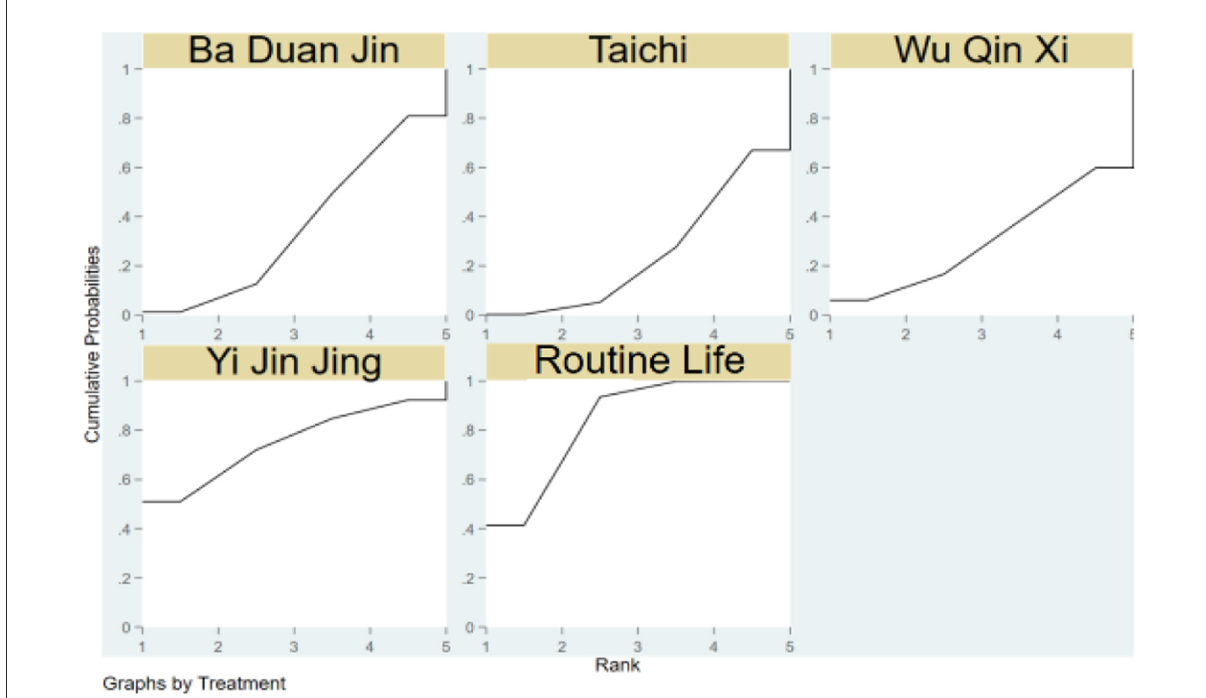
FIGURE6 SUCRA plots demonstrating cumulative likelihood of impact of traditional items on elderly ECLSB.